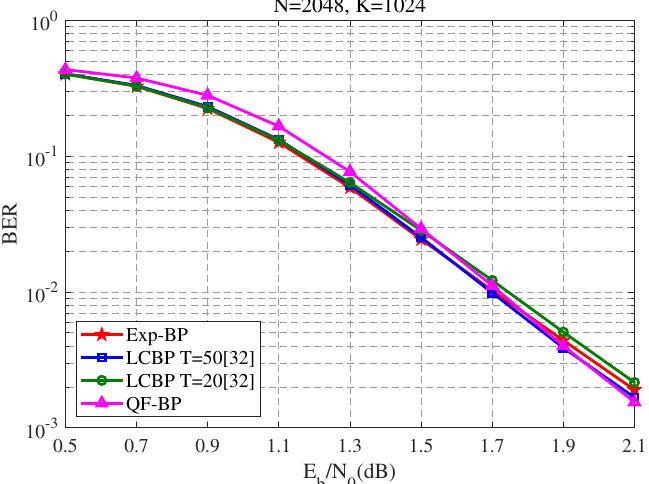
Figure 6. The BER performance of the proposed algorithms and the LCBP algorithm with different T